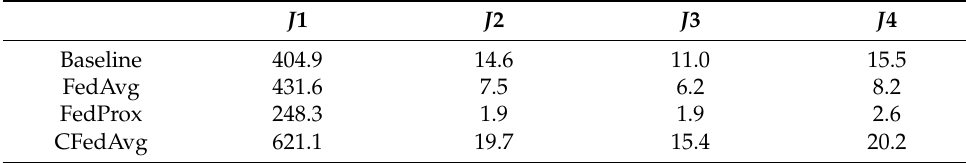
Table 6. Quantitative analysis of J